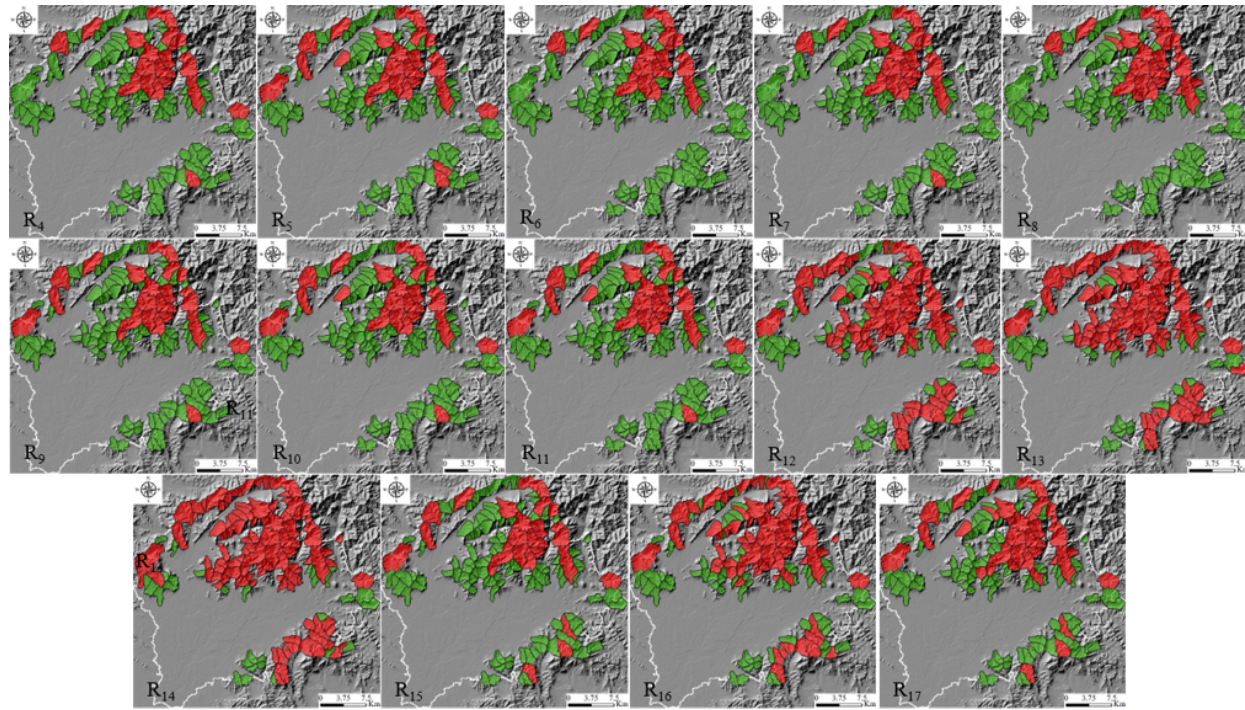
Figure 7. Results of two categories by natural breaks (Jenks)